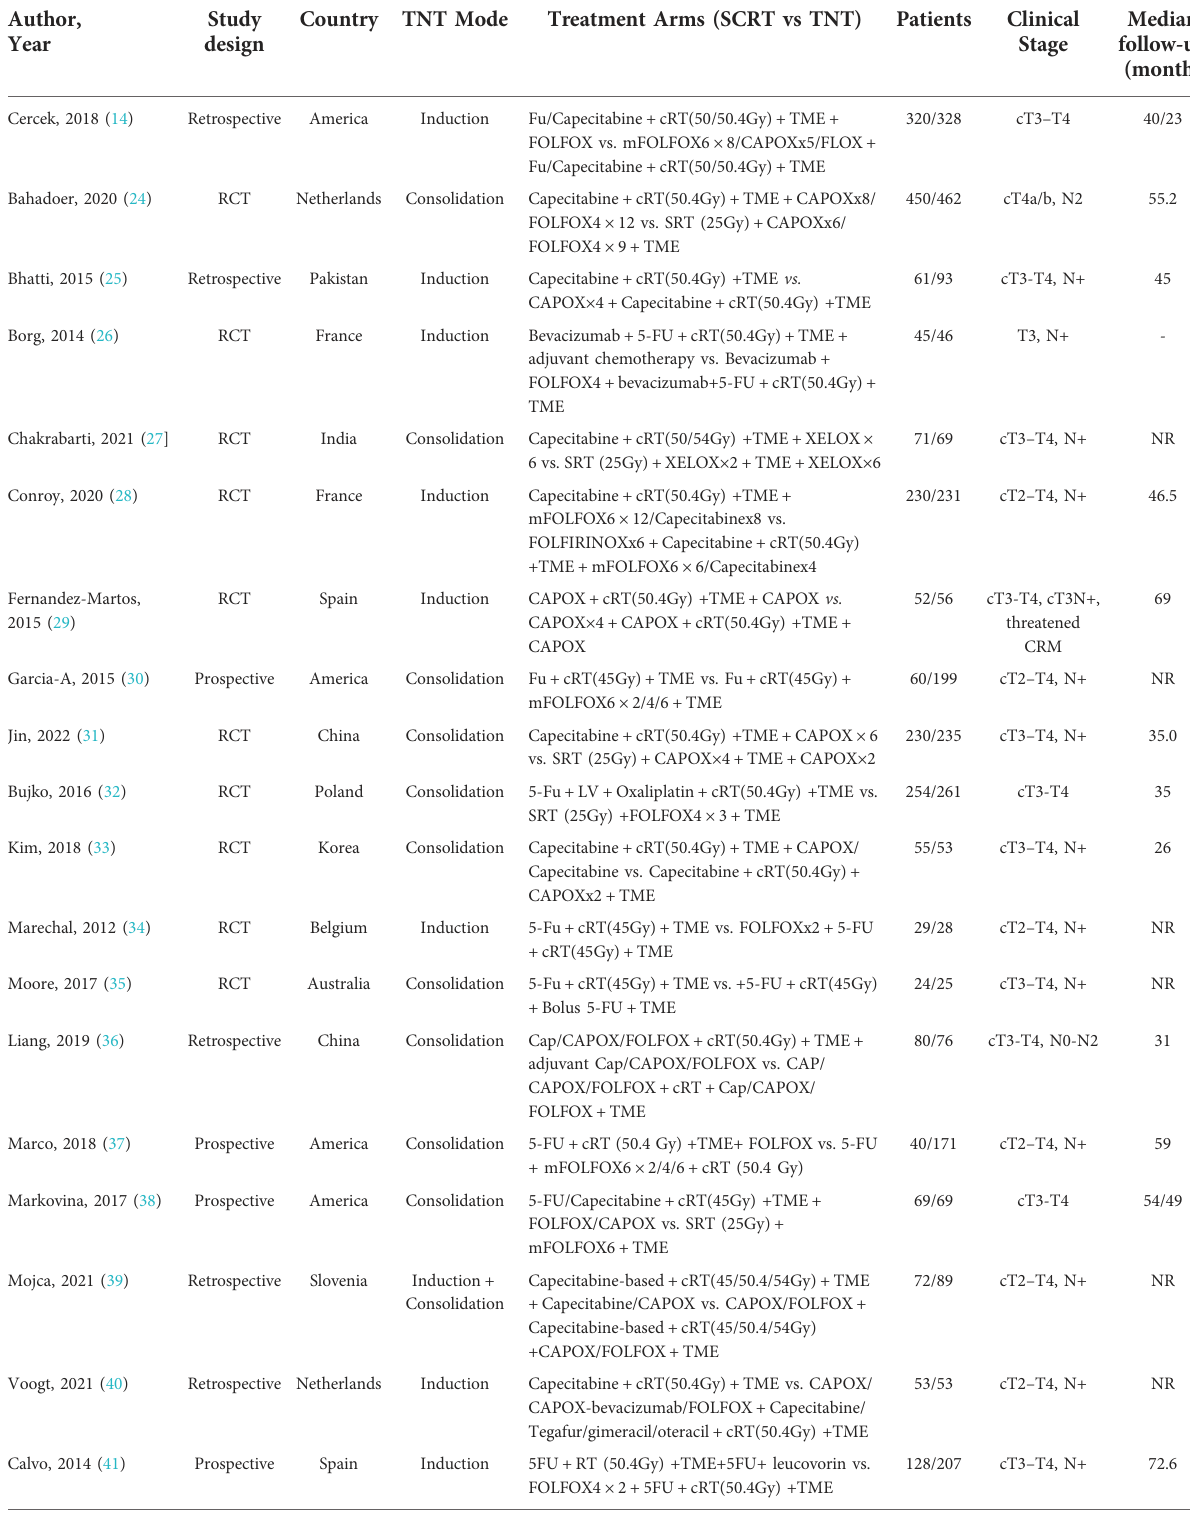
TABLE 1 Characteristics of studies included in